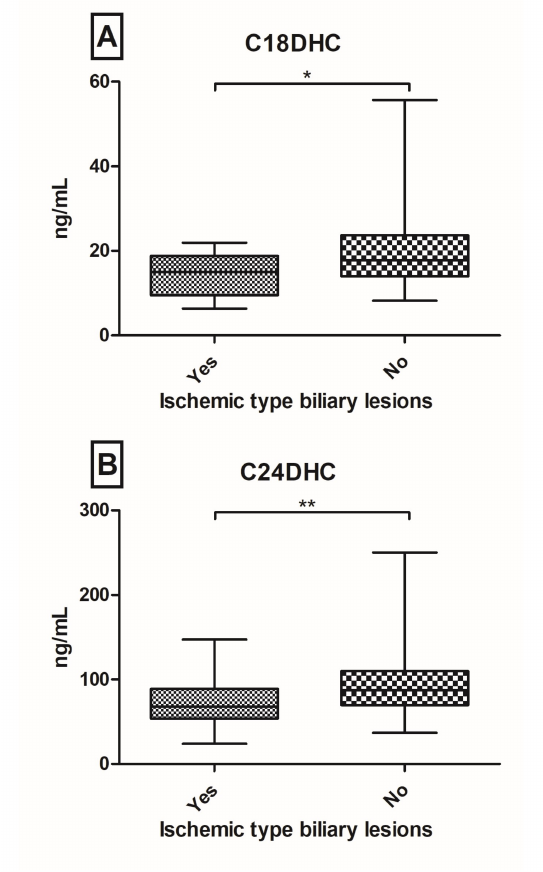
Figure 2. Serum dihydro-ceramides (DHC) in post-OLT patients with history of ischemic type biliary lesions. C18DHC ( A ) and C24DHC ( B ) are significantly down-regulated in patients with ischemic type biliary lesions (* p < 0.05; ** p <